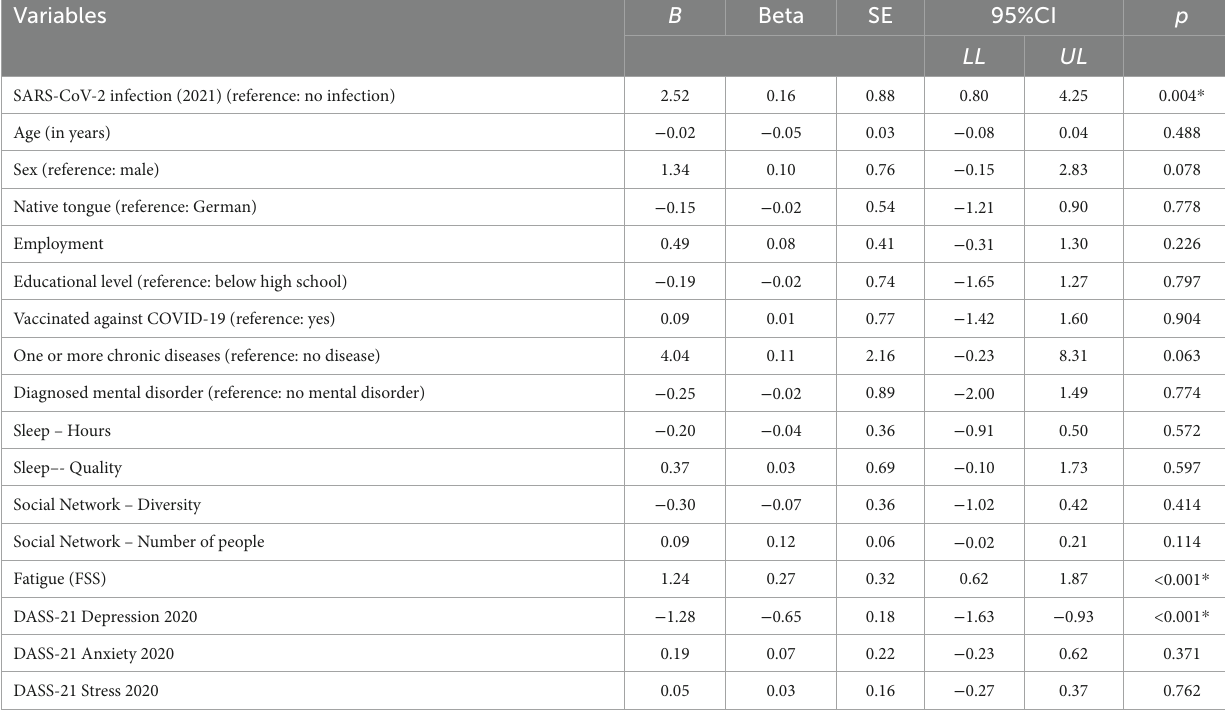
TABLE 4 Multiple linear regression analyses showing the association between confirmed SARS-CoV-2-infection and changes in depression (DASS-21 depression subscale) between 2020 and 2021 ( n = 305).